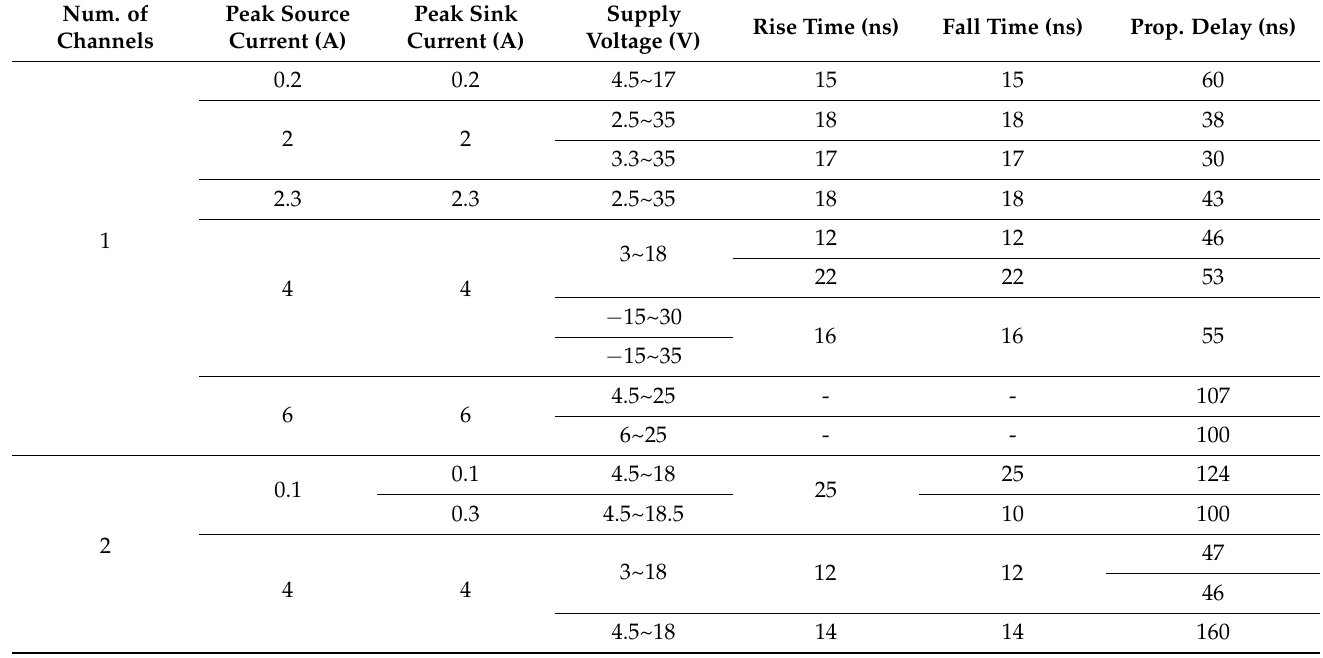
Table 35. Commercial SiC MOSFET drivers by Analog